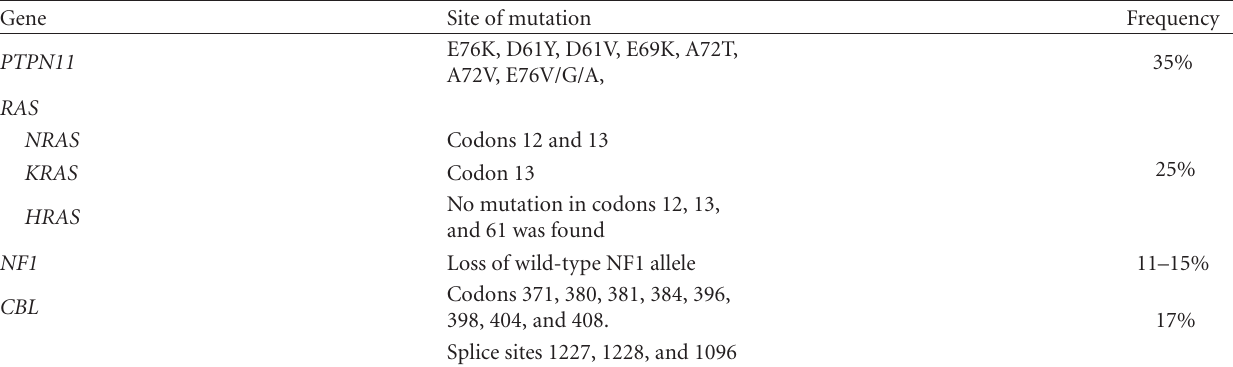
Table 1: Summary of genetic mutations in